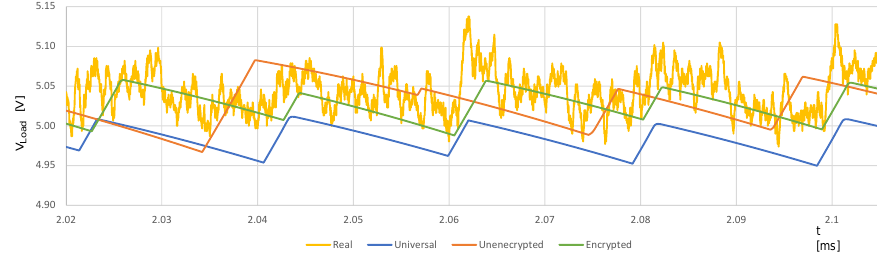
Figure 21. Detailed V Load models and real measurement time graph curves.